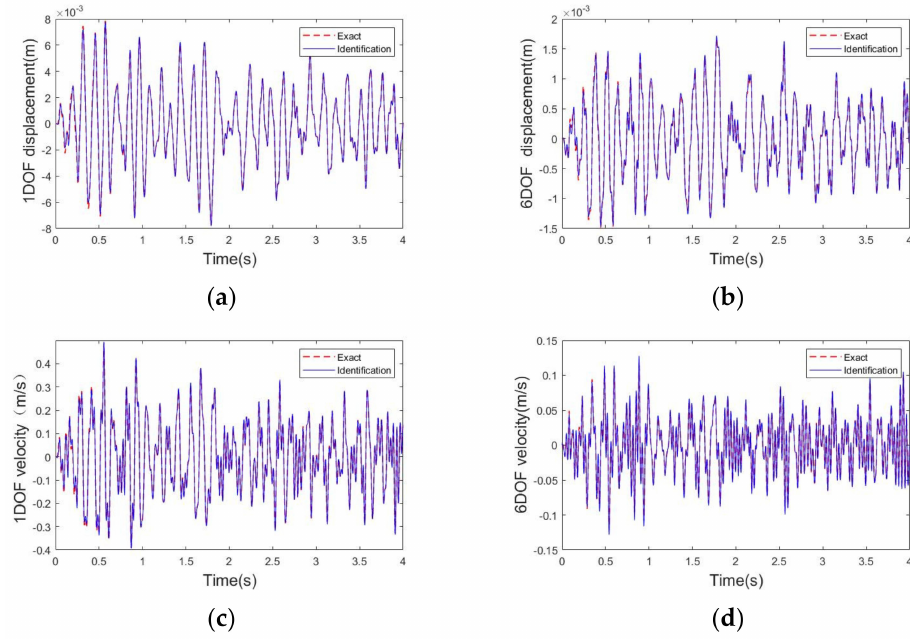
Figure 5. Comparisons of the exact and identified displacements and velocities. ( a ) Comparison of the exact and identified z 1 ; ( b ) comparison of the exact and identified z 6 ; ( c ) comparison of the exact . z 1 ; ( d ) comparison of the exact and identified and identified